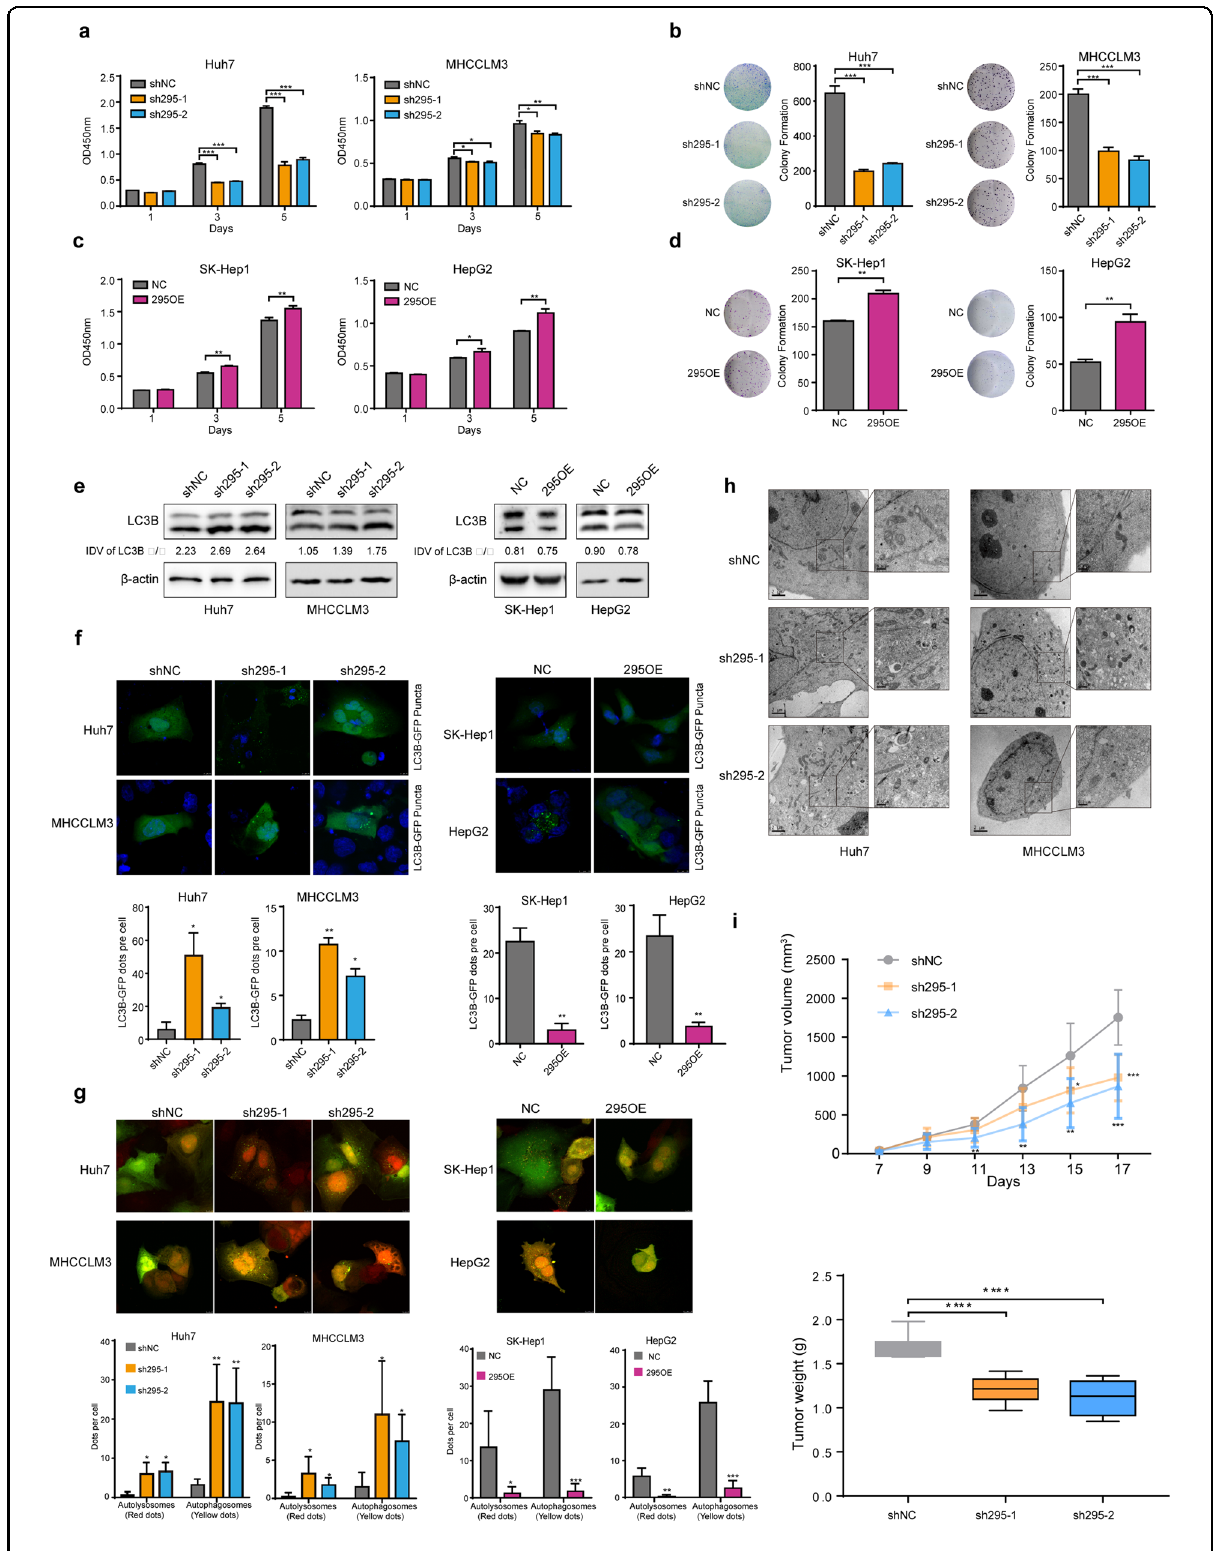
Fig. 2 (See legend on next